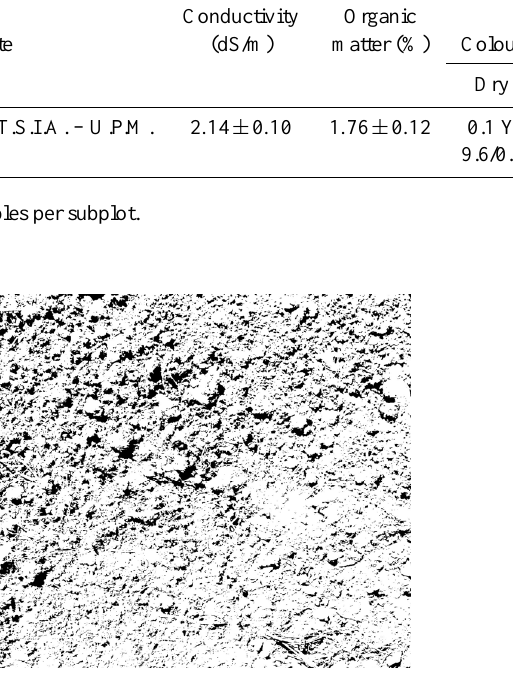
Fig. 3. Black and white image of a sandy loam soil tilled with tiller.